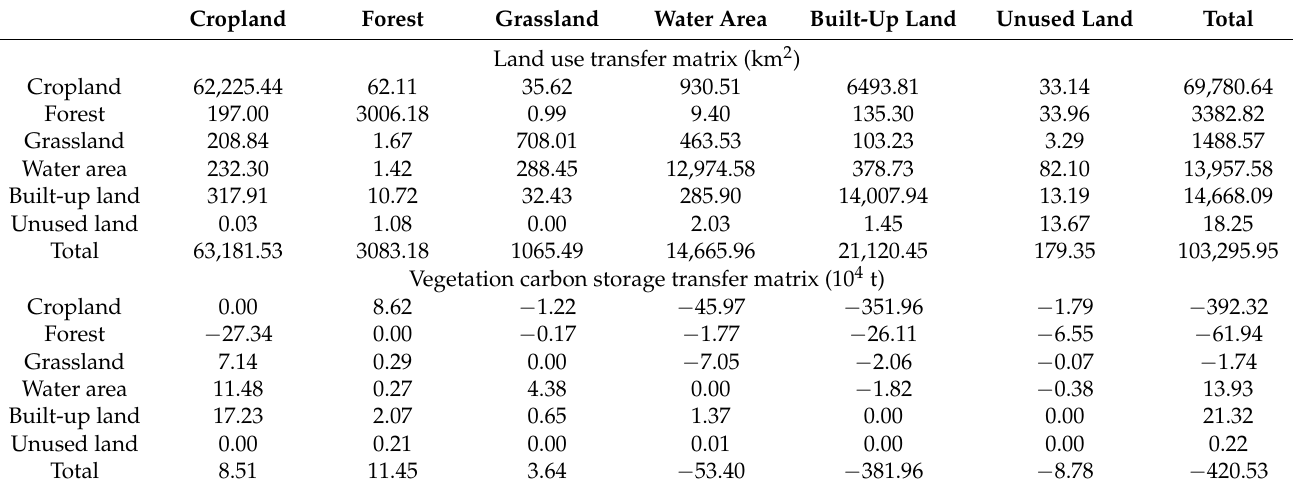
Table 4. Land use and carbon storage transfer matrix between 2000 and